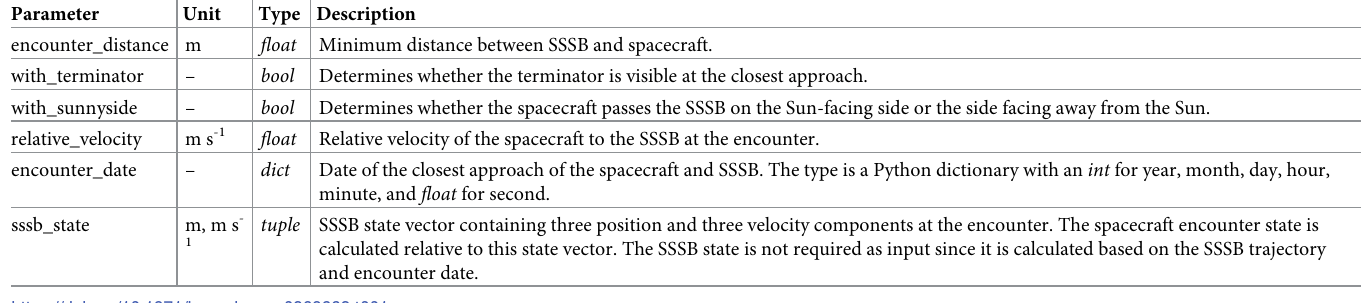
Table 1. Parameters defining the encounter state of the spacecraft in SISPO. The first five parameters are required as input. Parameter Unit